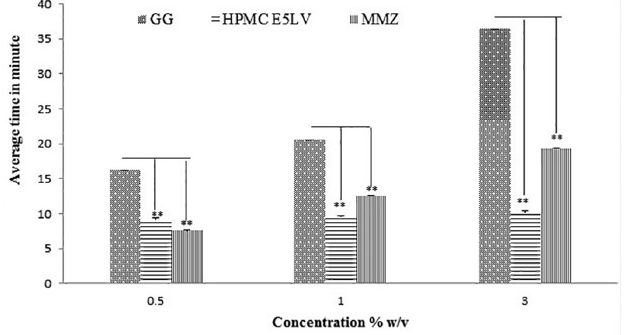
FIGURE 6 - Time taken by polymer coated grain to cover the given distance during falling sphere analysis. Values are expressed as mean ± SEM (n = 6). Data was analyzed by one way ANOVA followed by Dunnett test (Compared with standard Guar Gum), (ns) p>0.05; *p<0.05;